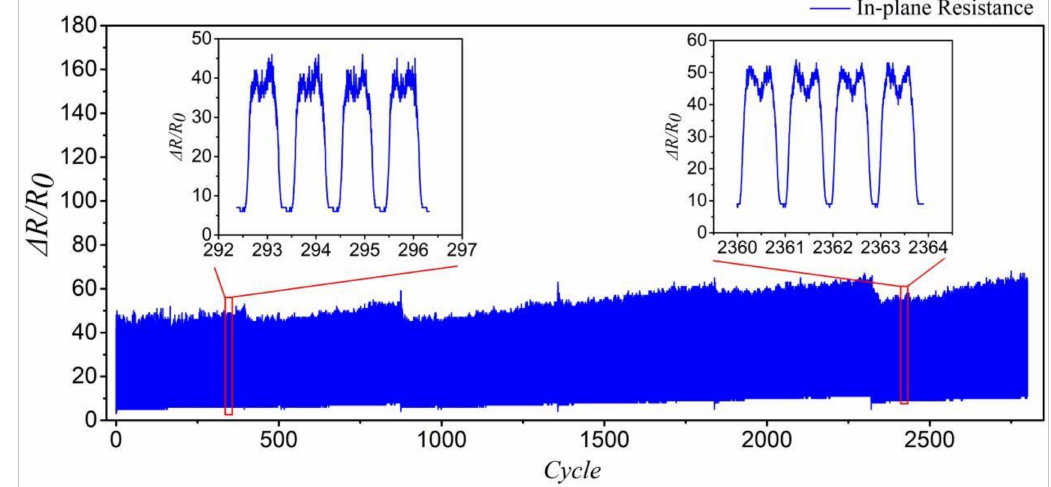
Figure 8. In-plane cycle stretching experiment. Table 1. ANOVA for the in-plane tensile cycle stretching experiment. Sum of